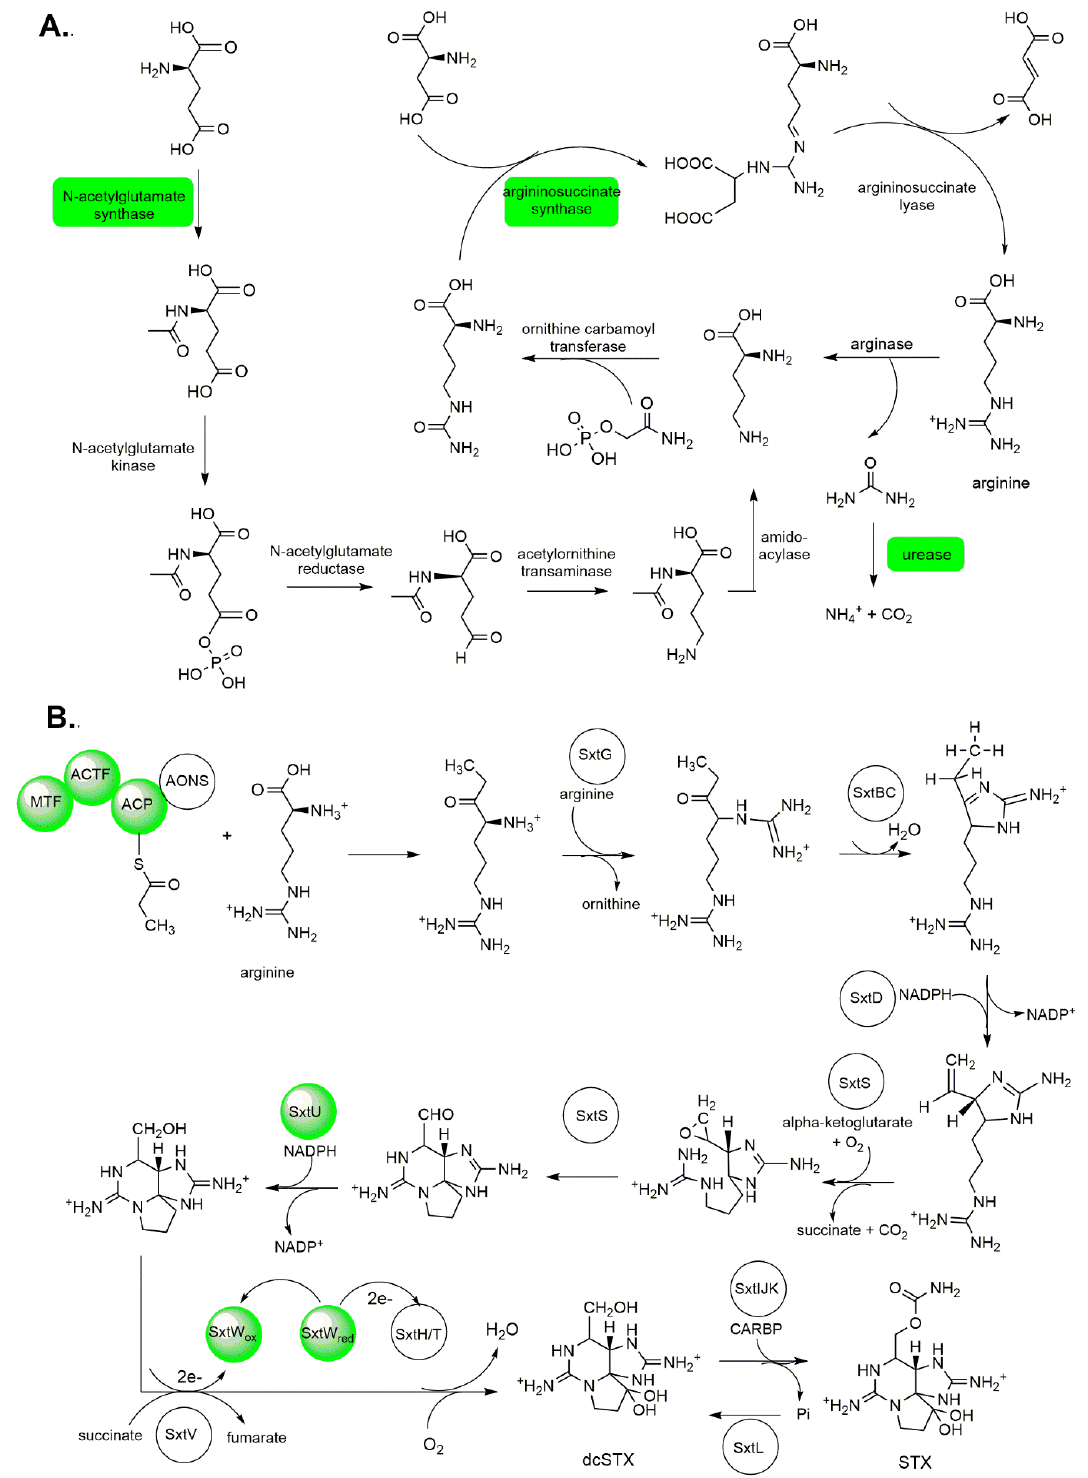
Figure 5. Arginine and paralytic shellfish toxin biosynthesis in P. bahamense : ( A ) Proteins involved in arginine biosynthesis such as ornithine decarboxylase, argininosuccinate synthase, ornithine-acyl-ACP acyltransferase, and bifunctional ornithine acetyltransferase/N-acetylglutamate synthase were detected in this study. Nitrogen metabolism in P. bahamense was mapped onto urea degradation, where carbon dioxide and ammonia are produced via the urease route. Figure adapted from Bromke et al. 2013 [60]. ( B ) Arginine serves as one of the building blocks for paralytic shellfish toxin biosynthesis. The detected proteins involved in arginine and PST biosynthesis in this study are highlighted in green. Figure adapted from Akbar et al. 2020 [59]. STX, saxitoxin; dcSTX,